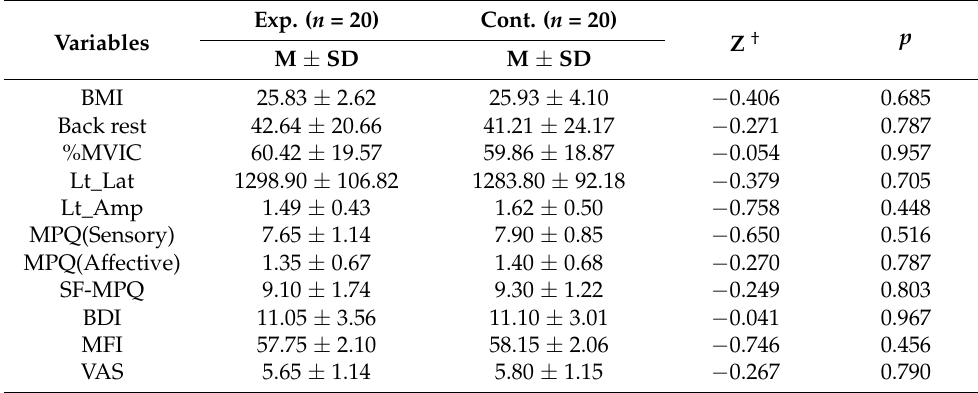
Table 2. Homogeneity test for the a priori dependent